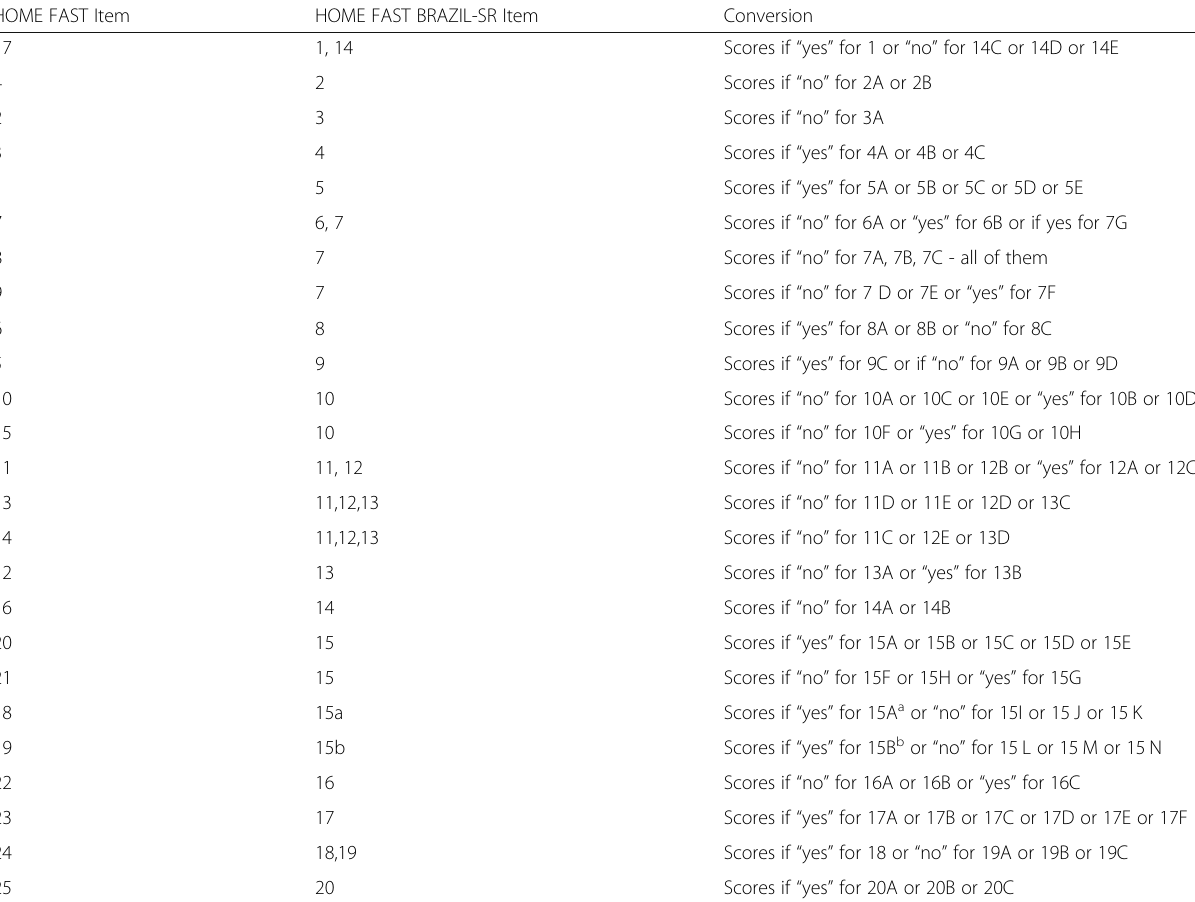
Table 4 HOME FAST BRAZIL-SR Score Conversion with the corresponding score of the 25 HOME FAST items, Curitiba, PR, Brazil, 2017 HOME FAST